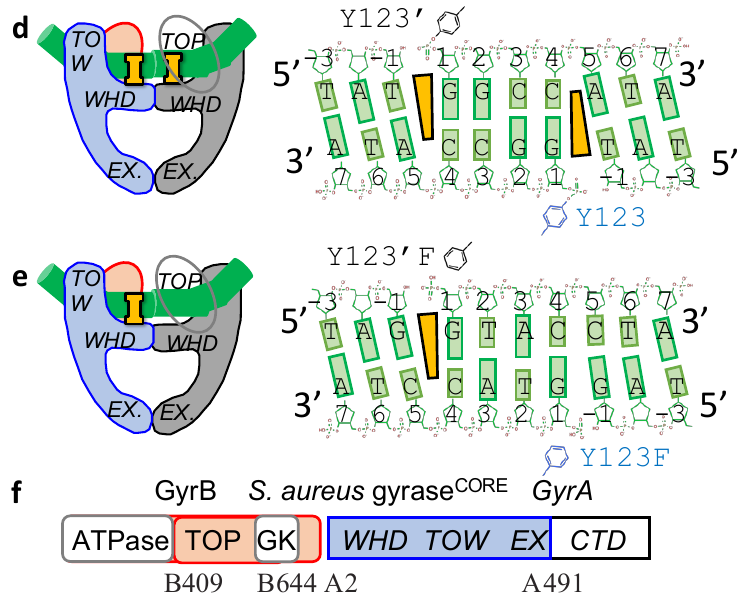
Figure 3. Type IIA topoisomerases and schematics of three etoposide crystal structures. ( a ) Simplified schematic of a reaction carried out by a type IIA topoisomerase. The gate or G-DNA (green cylinder) is cleaved and another DNA duplex, the T (or transport segment;-black) is passed through the cleaved DNA before religation. ( b ) Schematic of a 2.16Å human hTOP2 β core structure (pdb code: 3qx3) with DNA and two etoposides (I) binding at the two DNA cleavage sites, four base-pairs apart. One subunit is shown in red and blue, the other in grey. The DNA sequence (5 (cid:48) -3 (cid:48) ) is the same for both strands; the DNA has been cleaved by tyrosine 821. ( c ) In human TOP2 β is a single subunit and functions as a homodimer; the hTOP2 β core is residues 445-1201. Structural domains in hTOP2 β core are TOPRIM (TOP) domain, GK = Greek key domain, WHD = winged helical domain, TOW = tower domain, EX = exit gate domain. ( d ) Schematic of a 2.8Å structure of S. aureus gyrase CORE fusion truncate DNA complex containing two etoposide (I) binding at the two DNA cleavage sites (pdb code: 5cdn), four base-pairs apart. One gyrase CORE fusion truncate is shown in red and blue, the other in grey. ( e ) Schematic of a 2.45Å structure of S. aureus gyrase CORE fusion truncate DNA complex containing one etoposide (pdb code: 5cdp) (I) ( f ) DNA gyrase consists of two subunits, GyrB and GyrA (domains are indicated). Note in the S.aureus gyrase CORE fusion truncate the GyrB and GyrA subunits are fused into a single ‘subunit’ (B409-B644 + A2-A491) and the small greek key domain (residues B544-B579) has been